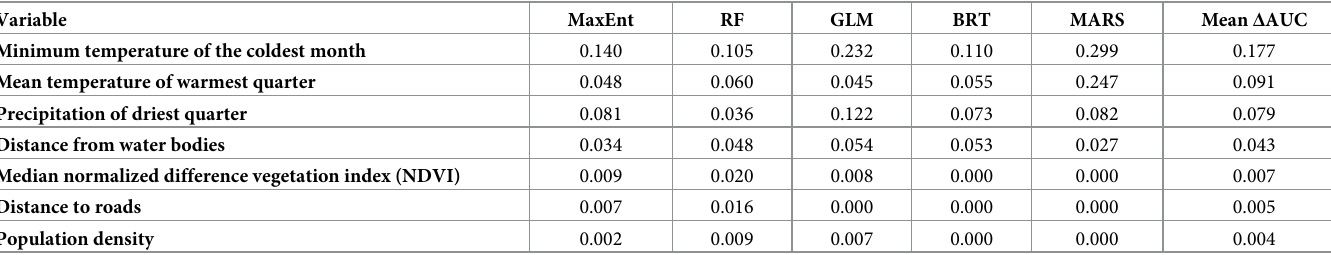
Table 2. Relative variable importance for each species distribution model using an increase in AUC values ( Δ